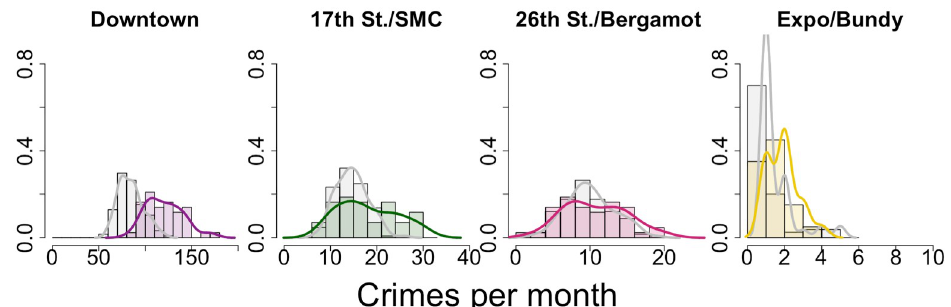
Fig 11. Reported crime near Expo Line light rail stations in Santa Monica, CA, 2006–2019, before and after opening of the light rail extension. These normalized histograms (bars) and densities (curves) provide monthly reported crime counts in a 450 meter radius around locations at which new stations opened in 2016. Gray represents the time period through May 2016, prior to this opening. Colored data is from the time period afterwards. Changes to the mean are statistically significant for the Downtown Santa Monica station, the 17 th Street/Santa Monica College station, and the Expo/Bundy station. They are not significant for the 26 th Street/Bergamot station. See Table 3.